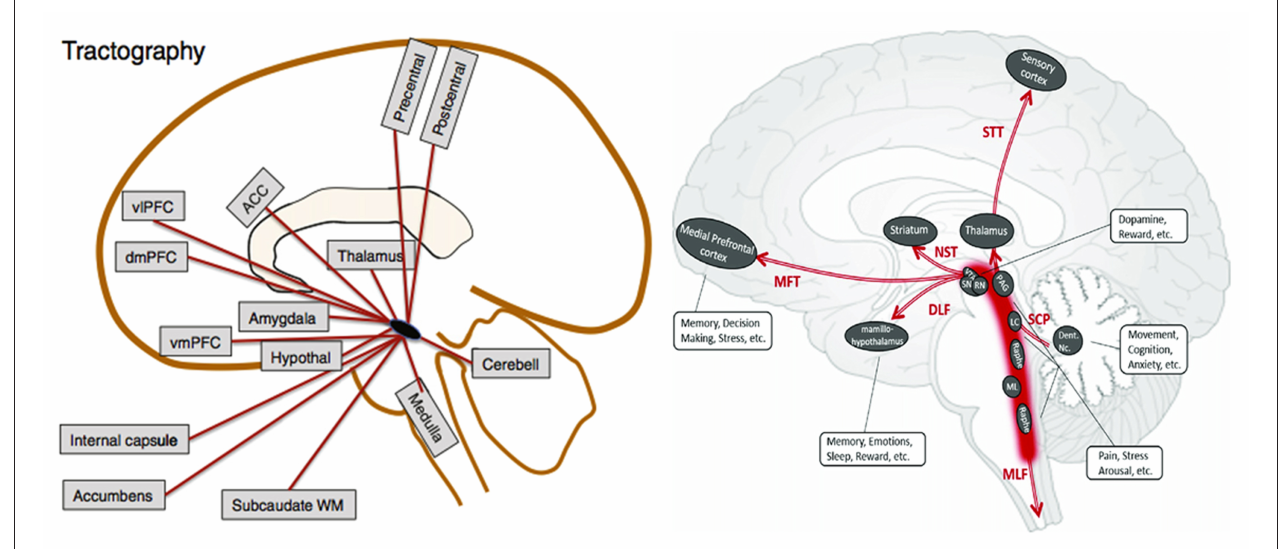
FIGURE 2 | Possible PAG connections based on DTI from Linnman et al. (84) and Zhang et al. (76). ACC, anterior cingulate cortex; Cerebell, cerebellum; dmPFC, dorsomedial prefrontal cortex; vmPFC, ventromedial prefrontal cortex; vlPFC, ventrolateral prefrontal cortex; WM, white matter; VTA, ventral tegmental area; SN, substantia nigra; RN, red nucleus; PAG, periaqueductal gray matter; LC, locus coeruleus; ML, medial lemniscus; Dent. Nc., dentate nucleus; STT, spinothalamic tract; NST, nigrostriatal tract; MFT, medial forebrain tract; DLF, dorsal longitudinal fasciculus; SCP, superior cerebellar peduncle; MLF, medial longitudinal